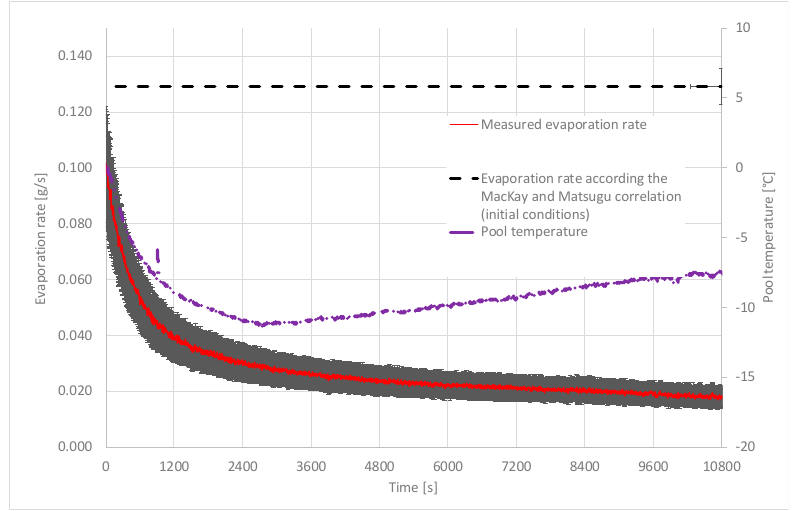
Figure 6. Evaporation rate and pool temperature over time for the small-scale reference case. The grey zone represents the uncertainties.